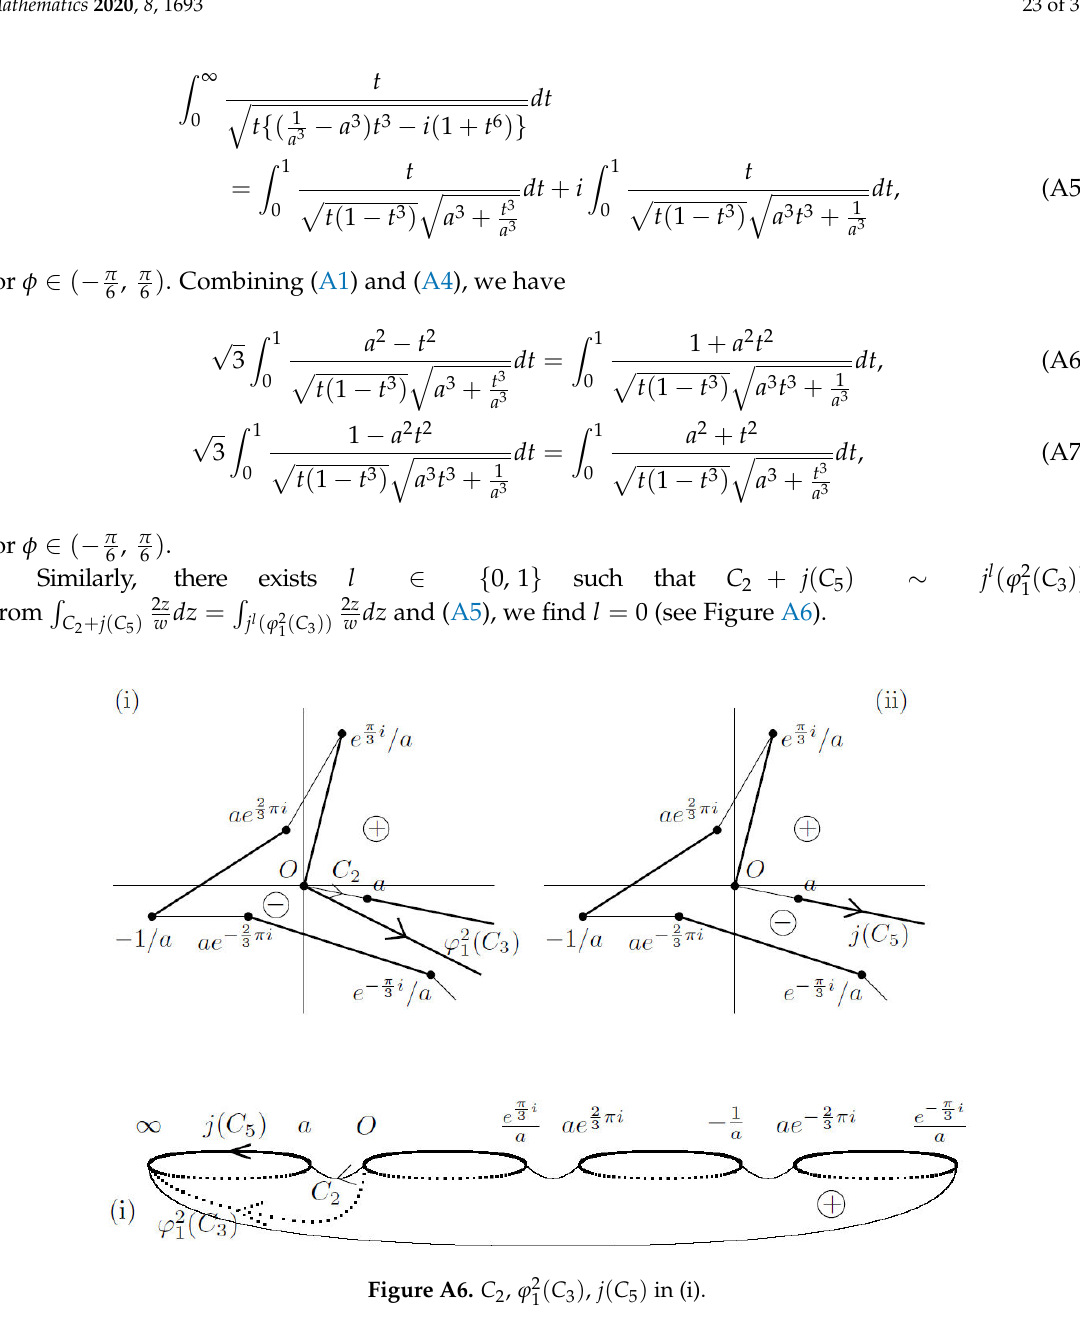
( C 3 ) , j ( C 5 ) in (i). 1